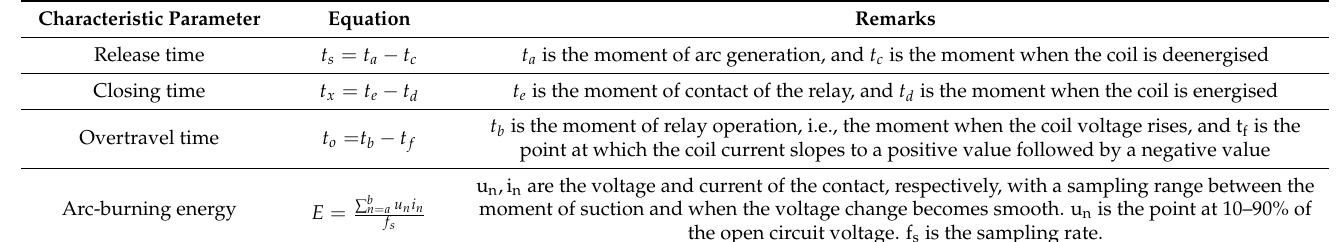
Table 1. Calculations of the main characteristic parameters of the